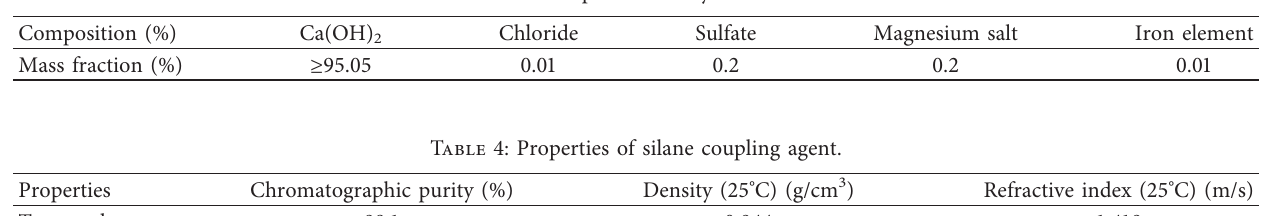
Table 3: Composition of hydrated lime.